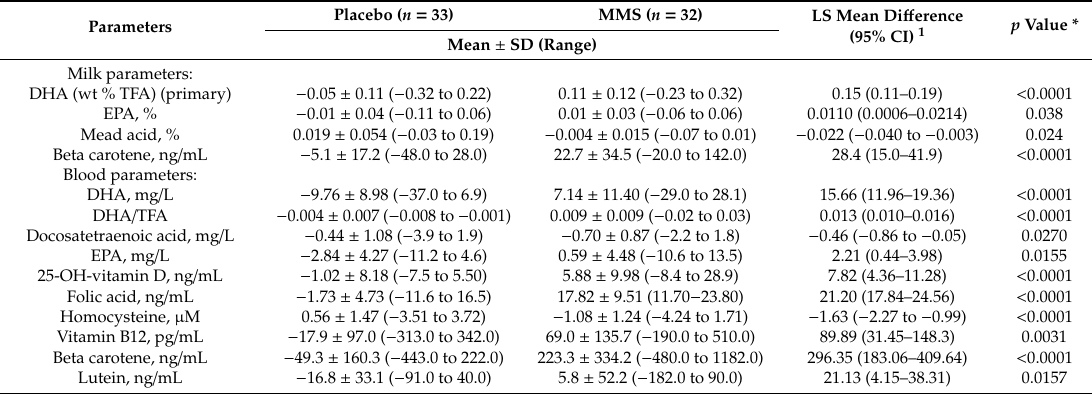
Table 2. Primary and secondary maternal e ffi cacy endpoints with significant changes reported from Visit 2 to Visit 4 (per protocol population, LOCF